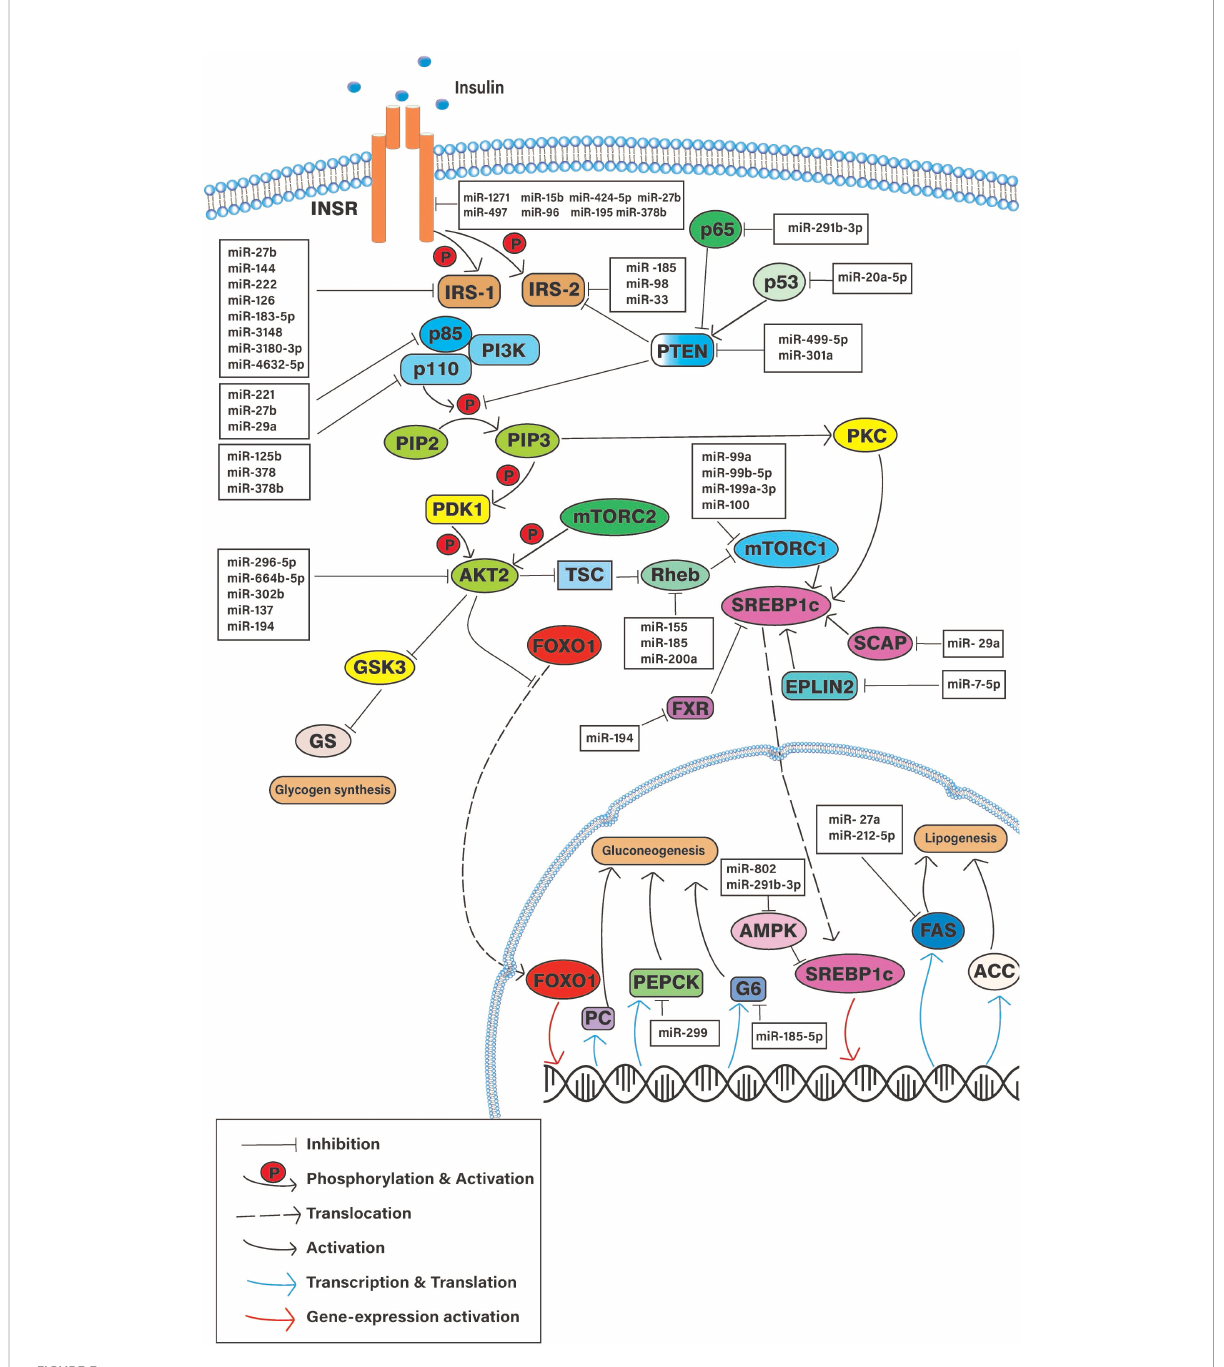
FIGURE 3 Schematic diagram of the cellular pathways involve in hepatic insulin resistance and potential regulatory microRNAs. INSR, Insulin signaling receptor; PTEN, Phosphatase and Tensin homologue; IRS-(1/2), Insulin receptor substrate; PI3K, Phosphoinositide 3-Kinase; mTORC1, Mammalian target of rapamicine complex-1; AKT2, Serine/Threonine kinase 2; aPKC, atypical protein kinase C; FOXO-1, Forkhead box-containing protein O subfamily-1; SREBP1, sterol regulatory element-binding protein 1c; PEPCK, phosphoenolpyruvate carboxykinase; G6 glucose, 6-phosphatase; FAS, fatty acid synthase; PC, Pyruvate kinase; ACC, Acetyl CoA carboxylase; SCAP, SREBP cleavage-activating